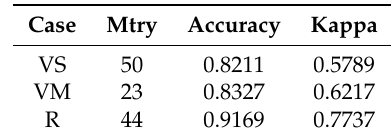
Table 3. Results of the adjustment of the mtry parameter.